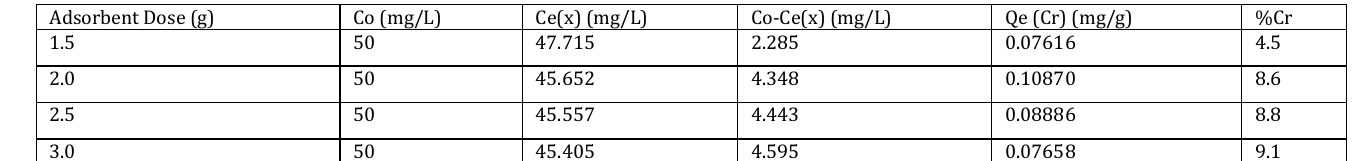
Table 6: Effect of adsorbent dose on the removal of Cr from aqueous solution